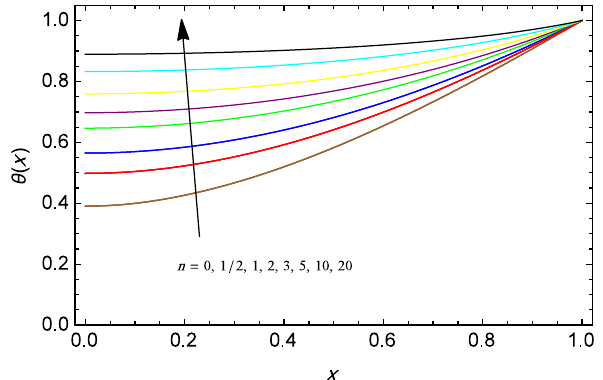
Figure 3: Diagram of θ x ( ) versus x for temperature distributions with M 1 = and β 1 = . 2